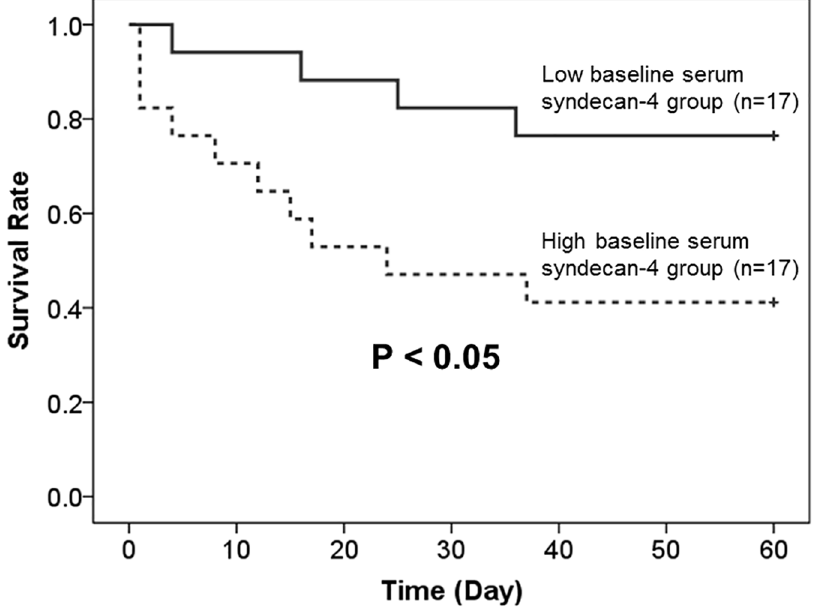
Fig 3. Kaplan Meier curves of the survival of patients with acute exacerbation of idiopathic interstitial pneumonia who were stratified according to median baseline serum syndecan-4 level. Baselineserum syndecan-4 levels measurements were obtainable for 34 of the 56 AE-IIP patients. The survival rate was significantly better for patients with low baselineserum syndecan-4levels than with high baselineserum syndecan-4 levels. (Low baselineserum syndecan-4group, < 12.8 ng/ml; High baselineserum syndecan-4 group, (cid:21) 12.8 ng/ml.) A log-ranktest was used for statistical analysis.